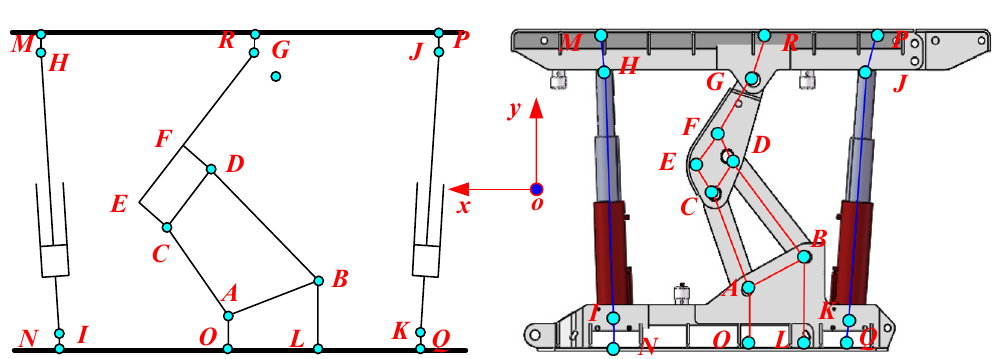
Figure 6. Upper and lower spacing deviation of advance hydraulic support: ( a ) ideal supporting state; ( b ) non- ideal supporting state (left bank); and ( c ) non-ideal supporting state (right bank).